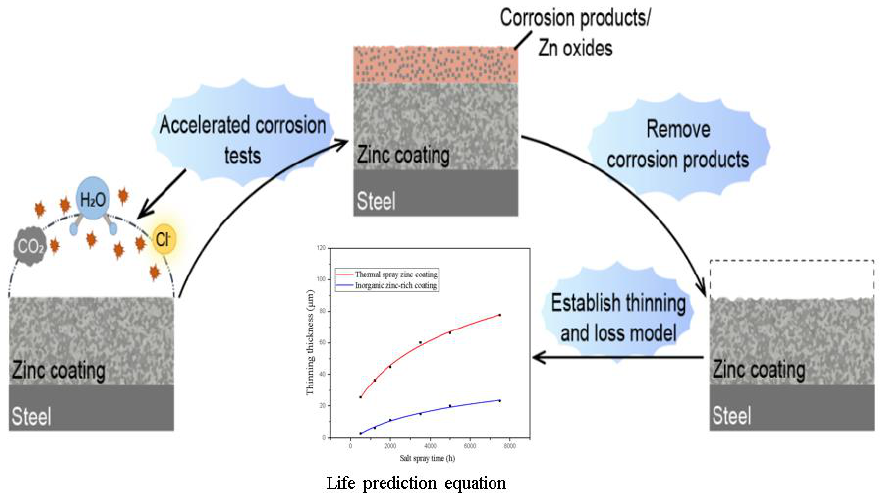
Figure 1. Interfacial corrosion thinning and weight-loss test process.